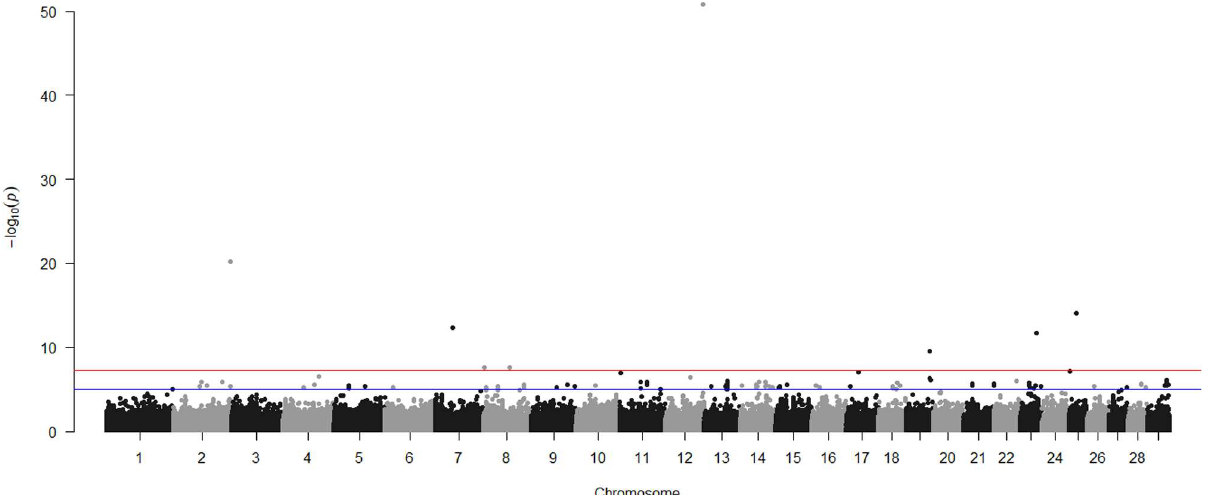
Fig 2. Manhattan plot of genome-wide single nucleotide polymorphisms (SNPs) associated with overall response to vaccination with E . coli O157: H7 Siderophore and Receptor Porin (SRP) proteins in calves ( n = 651). Red line = Genome-Wide Significance Level ( P < 5 x 10 − 8 ); Blue line = Suggestive Significance Level ( P < 1 x 10 −5 ). A genomic relationship matrix was used for this Manhattan Plot, but similar results were obtained using a pedigree relationship matrix (results not